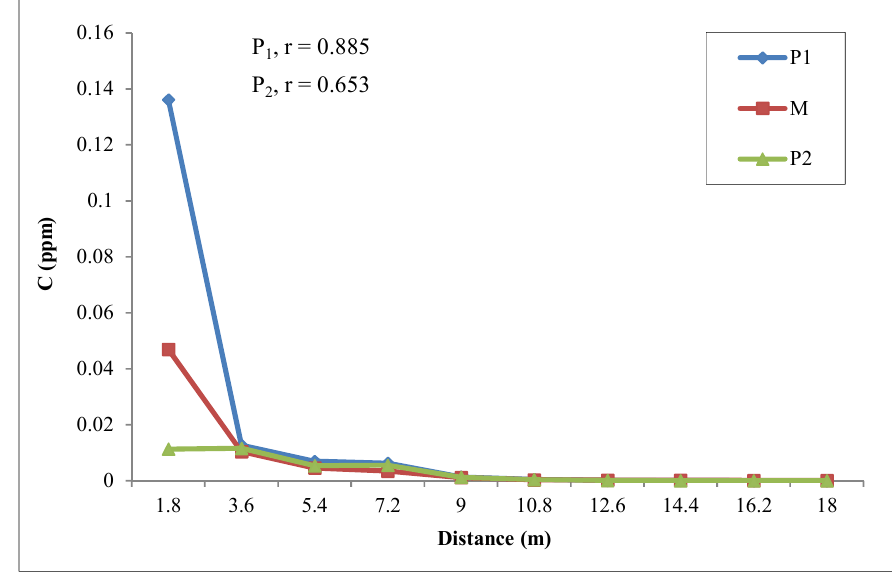
Figure 5. Measured and predicted Concentrations against Distance for the month of September.